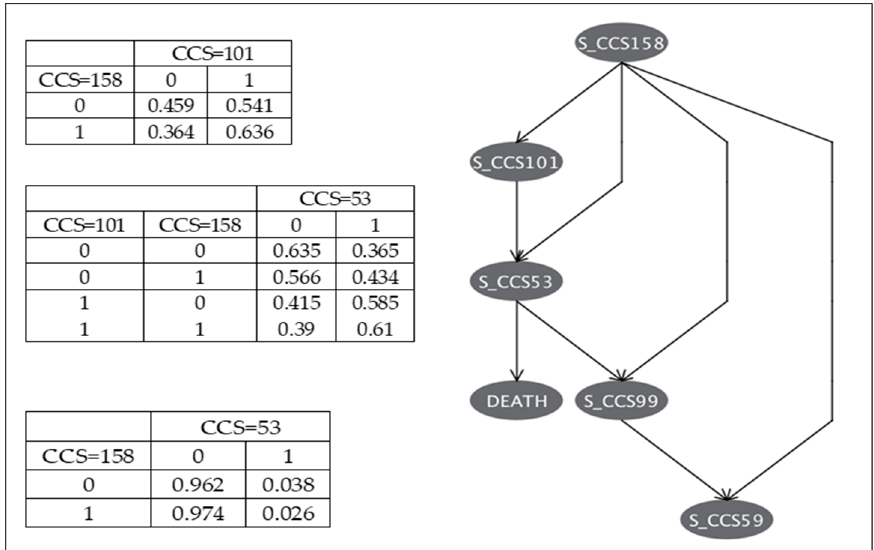
Figure 3. Right: Bayesian Network of CHF Comorbidities included in the most frequent cluster. Left: Probability distribution tables for the path Left: Probability distribution tables for the path {(CCS158 → CCS101) → CCS53 → {(CCS158  CCS101)  CCS53  DEATH}.